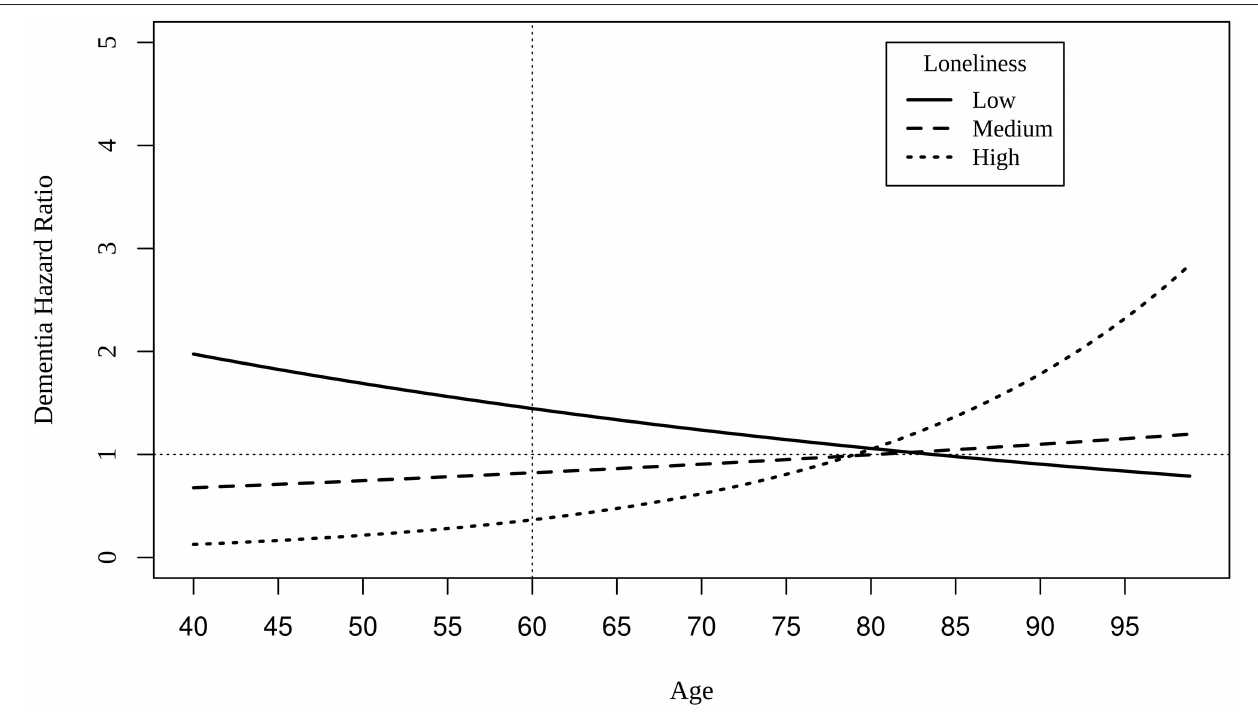
FIGURE 2 | Hazard ratios of dementia for different levels of loneliness as a function of age at intake. The dotted vertical line indicates the centering age of 60, and the dotted horizontal represents hazard ratio value of 1.00. Low